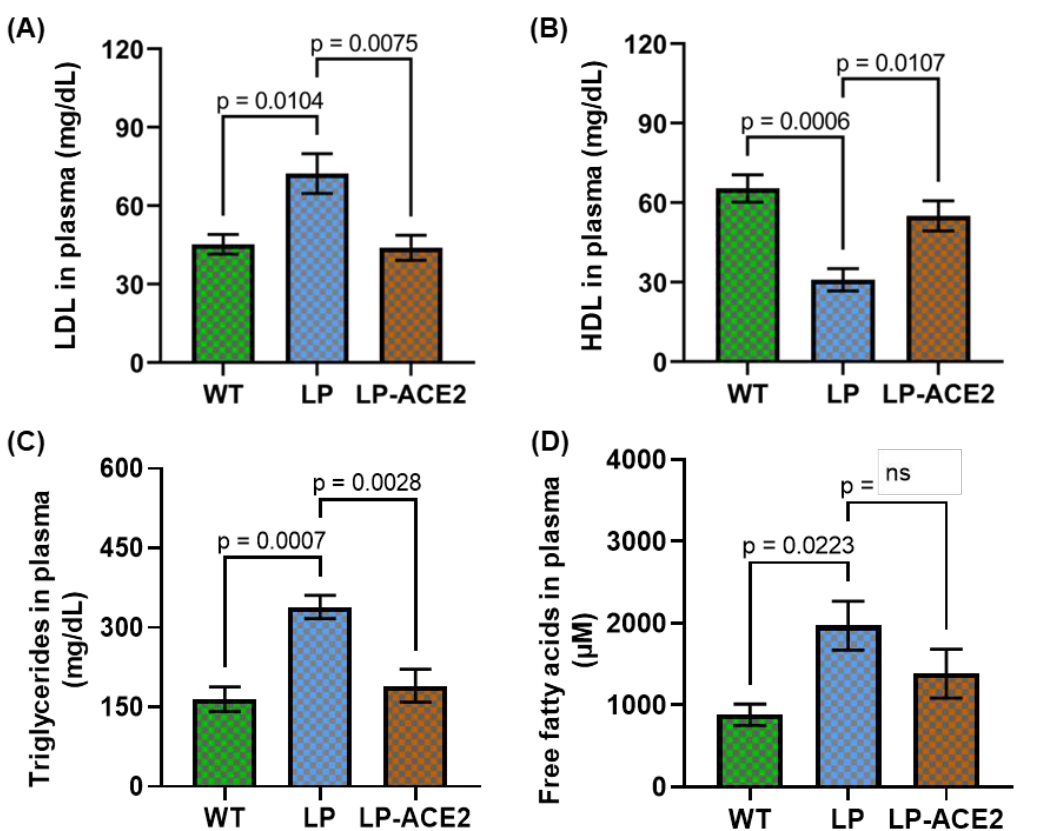
Figure 2. Effect of LP-ACE2 on circulating lipid profile in Akita and WT cohorts. The levels of LDL- cholesterol ( A ) and HDL-cholesterol ( B ), Triglycerides ( C ), and free fatty acids ( D ) were measured in the plasma samples. Data are calculated as mg/dL and presented as mean ± S.E.M. Statistical significance is analyzed by one-way ANOVA adjusted to account for multiple comparisons using Tukey’s test ( n = 6).